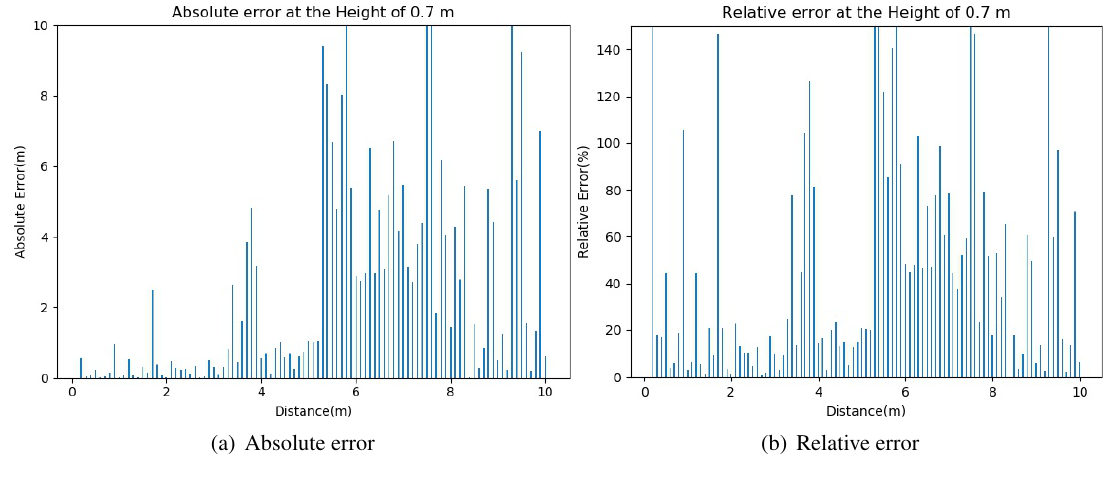
Fig. 3 Effect of Gaussian filter.